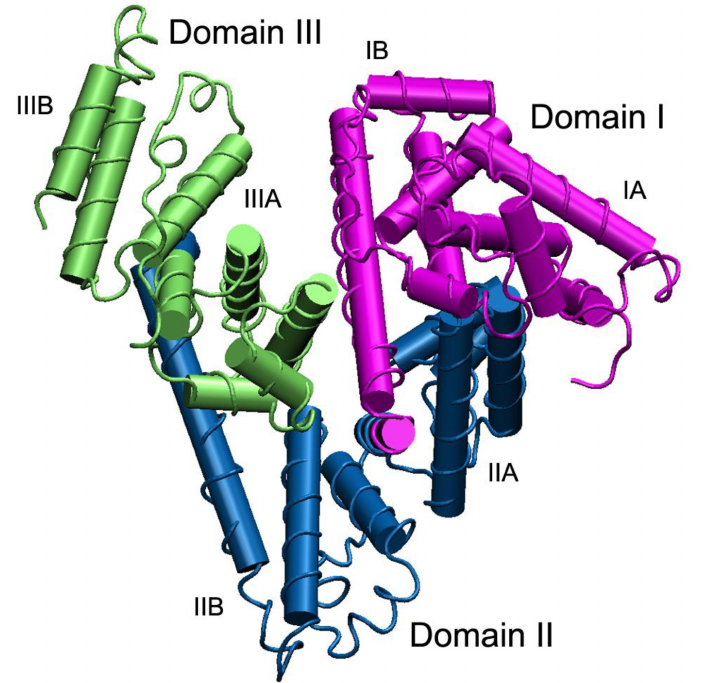
Figure 2. Three-dimensional structure of human serum albumin. The three domains I, II, and III are highlighted in purple, blue and green, respectively, and for each domain the two subdomains A and B are shown—from Belinskaia et al.